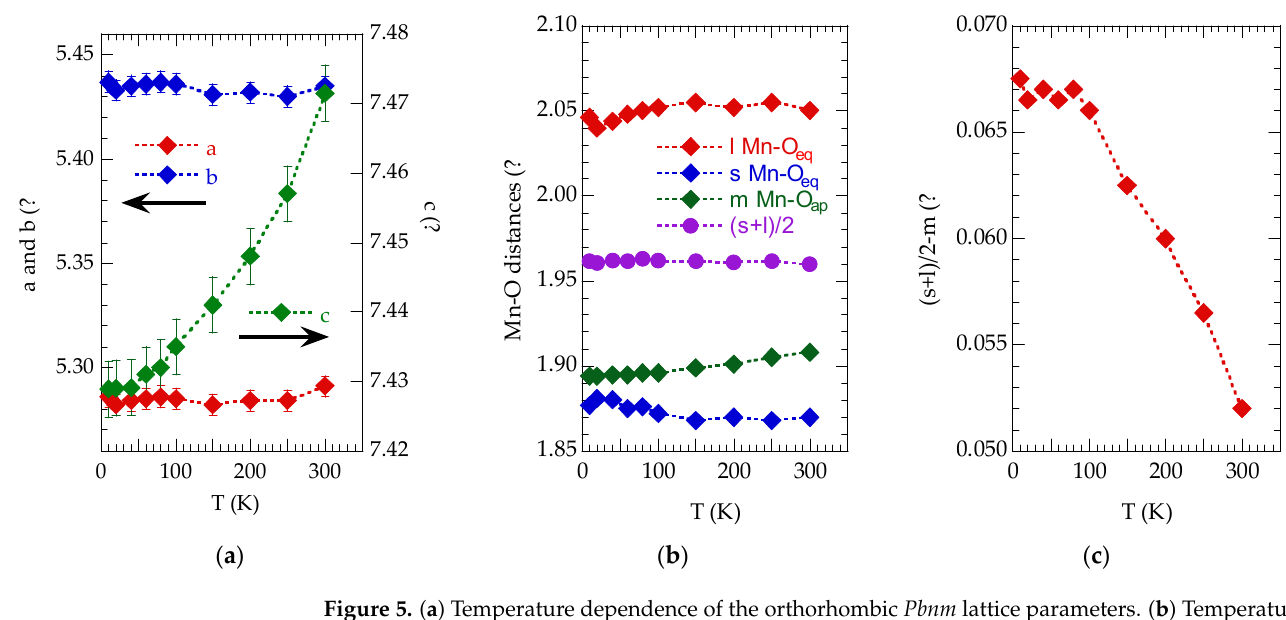
Figure 5. ( a ) Temperature dependence of the orthorhombic Pbnm lattice parameters. ( b ) Temperature dependence of the Mn-O distances and of the mean (s + l)/2 of the two equatorial short (s Mn-O eq ) and long (l Mn-O eq ) ones. ( c ) Temperature dependence of the Q 3 -type apical octahedra compression (see text for details).